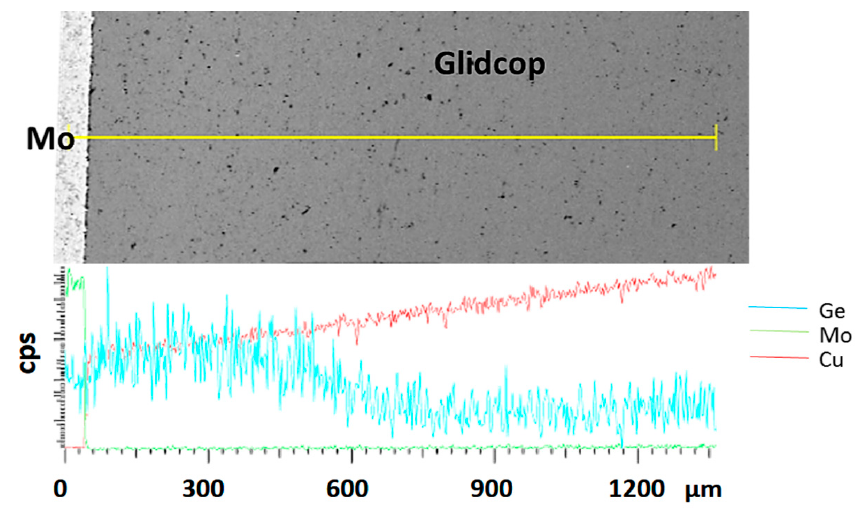
Figure 7. Element distribution (Ge, Cu and Mo) across the 1- µ m thick Cu plated Glidcop/braze/Mo joint.